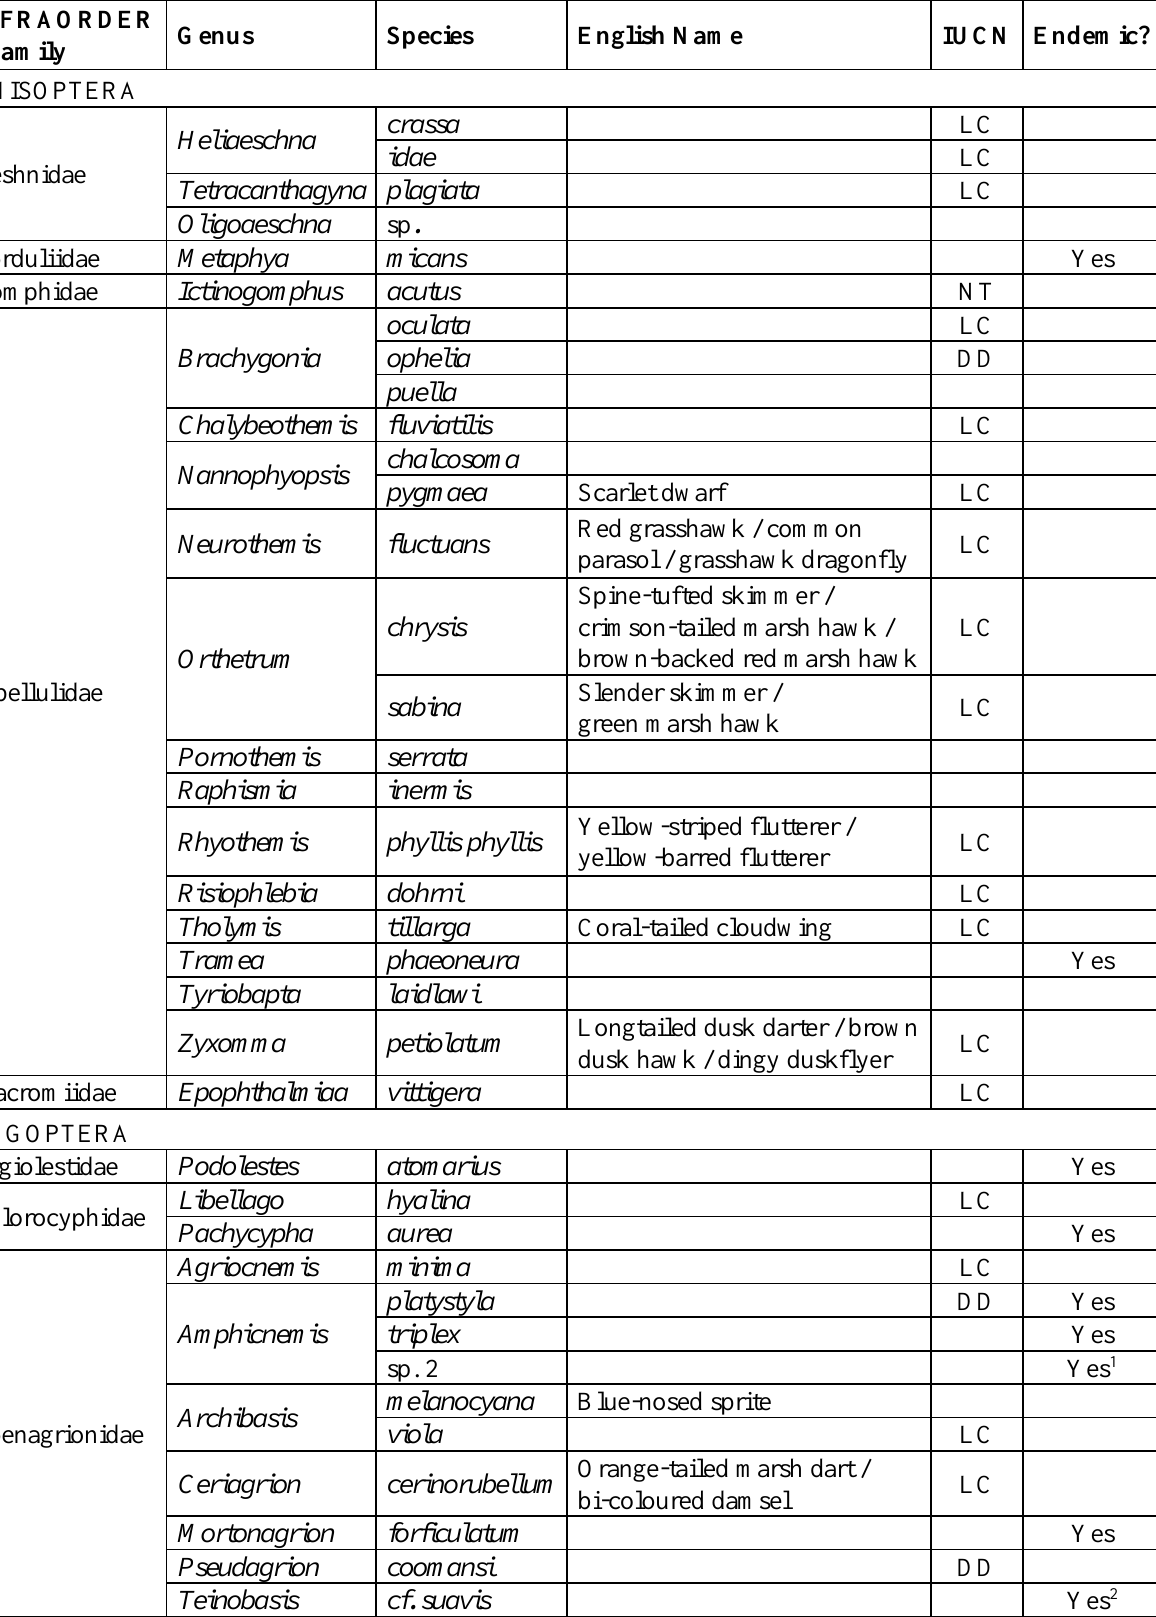
Table A5. List of dragon/damselfly (Odonata) species recorded in the NLPSF, Sebangau, together with IUCN Red List classifications (DD = data deficient; LC = least concern; NT = near threatened) and Borneo endemic species assignments. None of these species are included in the Indonesian protected species list. Slashes indicate alternative English